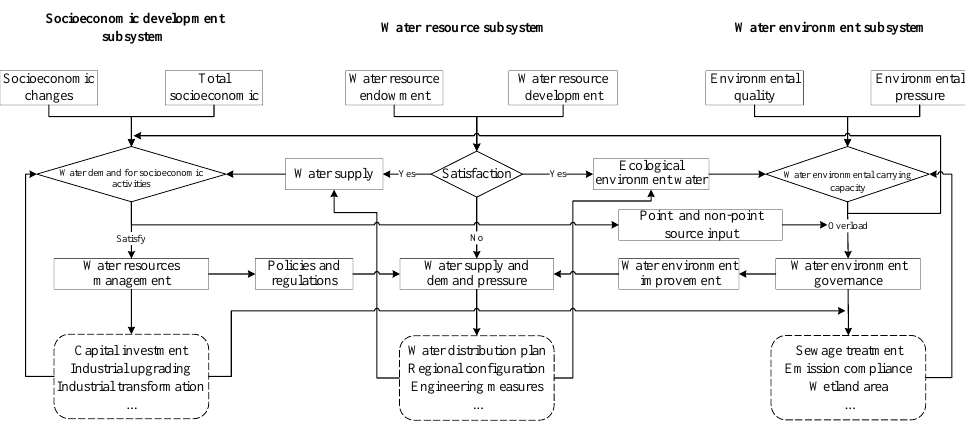
Figure 2. Synergetic relationship of the “water resource– water environment – socioeconomic devel- opment” coupling system.